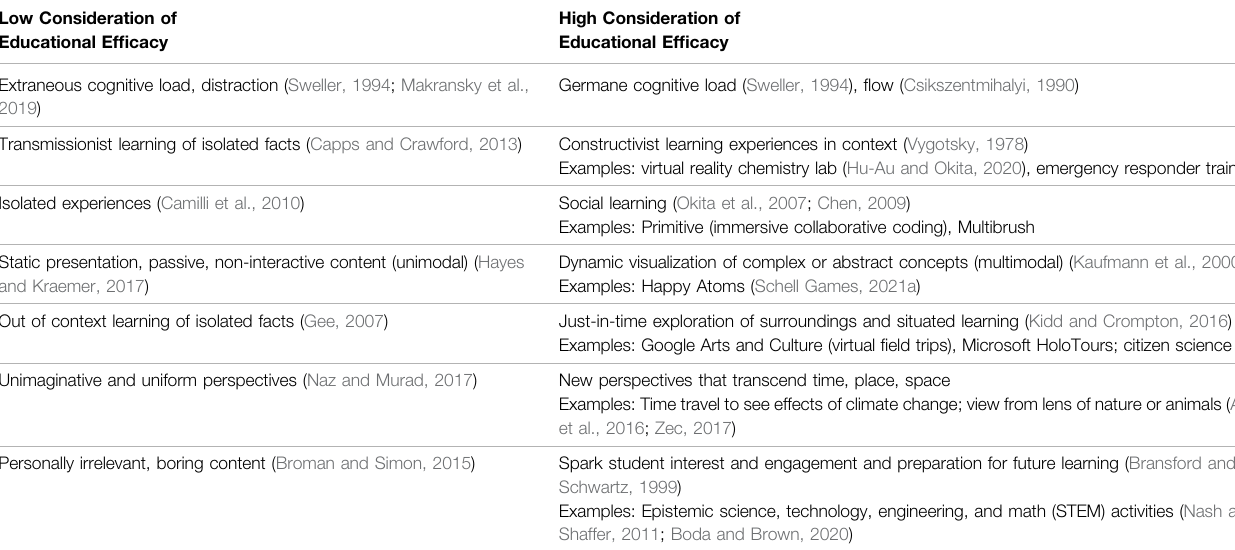
TABLE 3 | Low vs High Consideration of Educational Ef fi